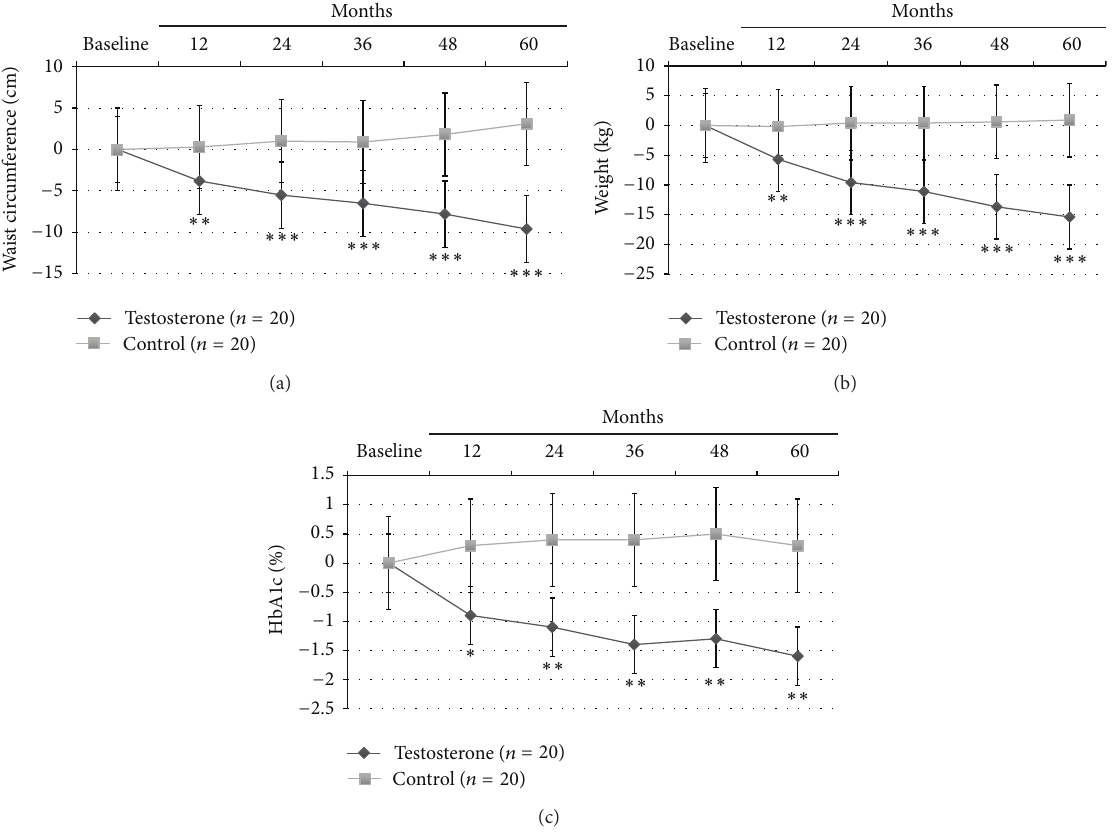
Figure 1: Effects of 5-year treatment with long-acting TU on (a) waist circumference (cm), (b) body weight (Kg), and (c) glucose homeostasis (HBA1c) in 40 hypogonadal men (T < 11nmol/L) with metabolic syndrome (IDF). 𝑃 variations were evaluated yearly in the testosterone treatment (TRT) versus controls (CTRL).